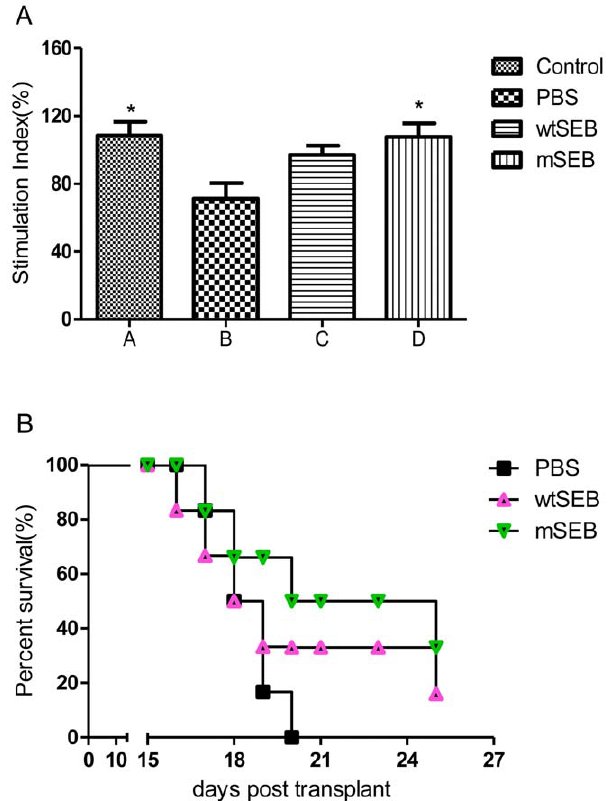
Figure 5. Effect of mSEB on survival rates and T lymphocyte transformation in the mouse Lewis lung carcinoma model. The tumor-bearing mice were given wtSEB or mSEB at 250 m g/kg, or PBS alone. (A) ConA-induced mouse lymphocyte transformation test (n=6). Comparison versus PBS-treated group: * P , 0.05. (B) mSEB administration protected against tumor-related mortality in mice. PBS was used as a negative control (n=12).